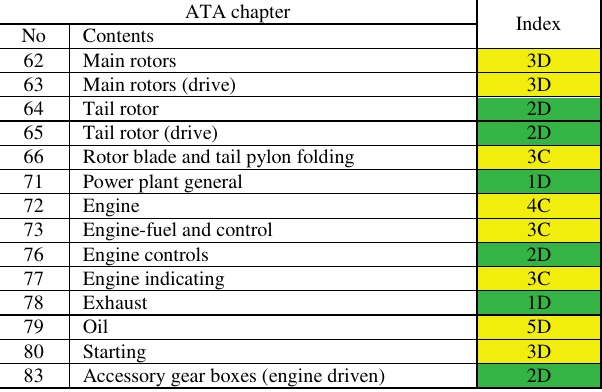
Fig. 23. Basic features of modern turbofan engine [18]: 1 – engine inlet, 2 – fan, external duct, 3 – low pressure compressor internal duct, 4 – high